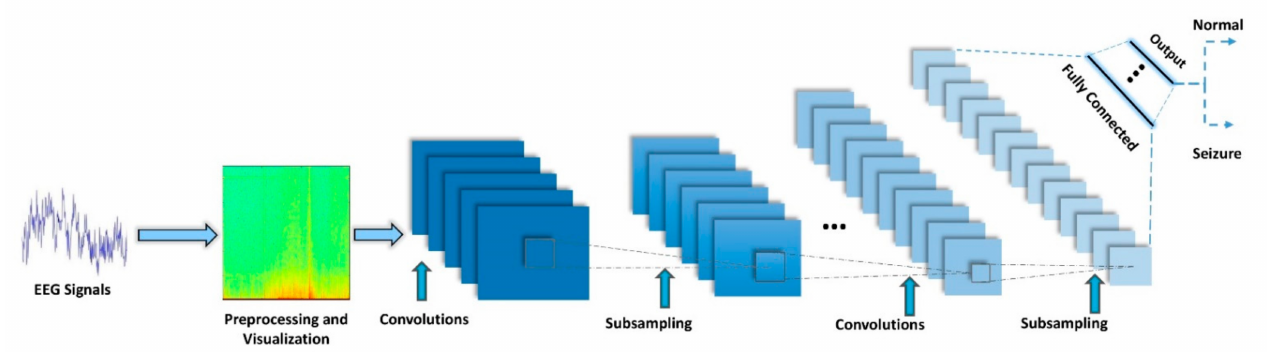
Figure 6. A typical 2D-CNN for epileptic seizure